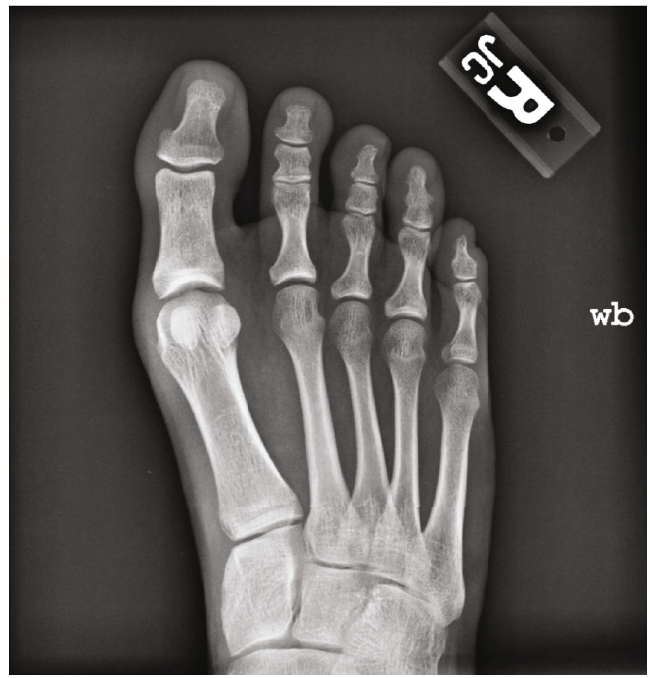
Figure 1: Preoperative right foot anteroposterior radiograph taken at the time of presentation.